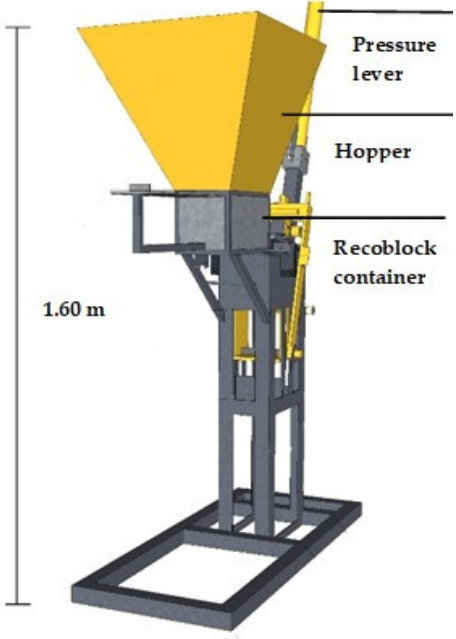
Figure 2. Recoblock molding machine.